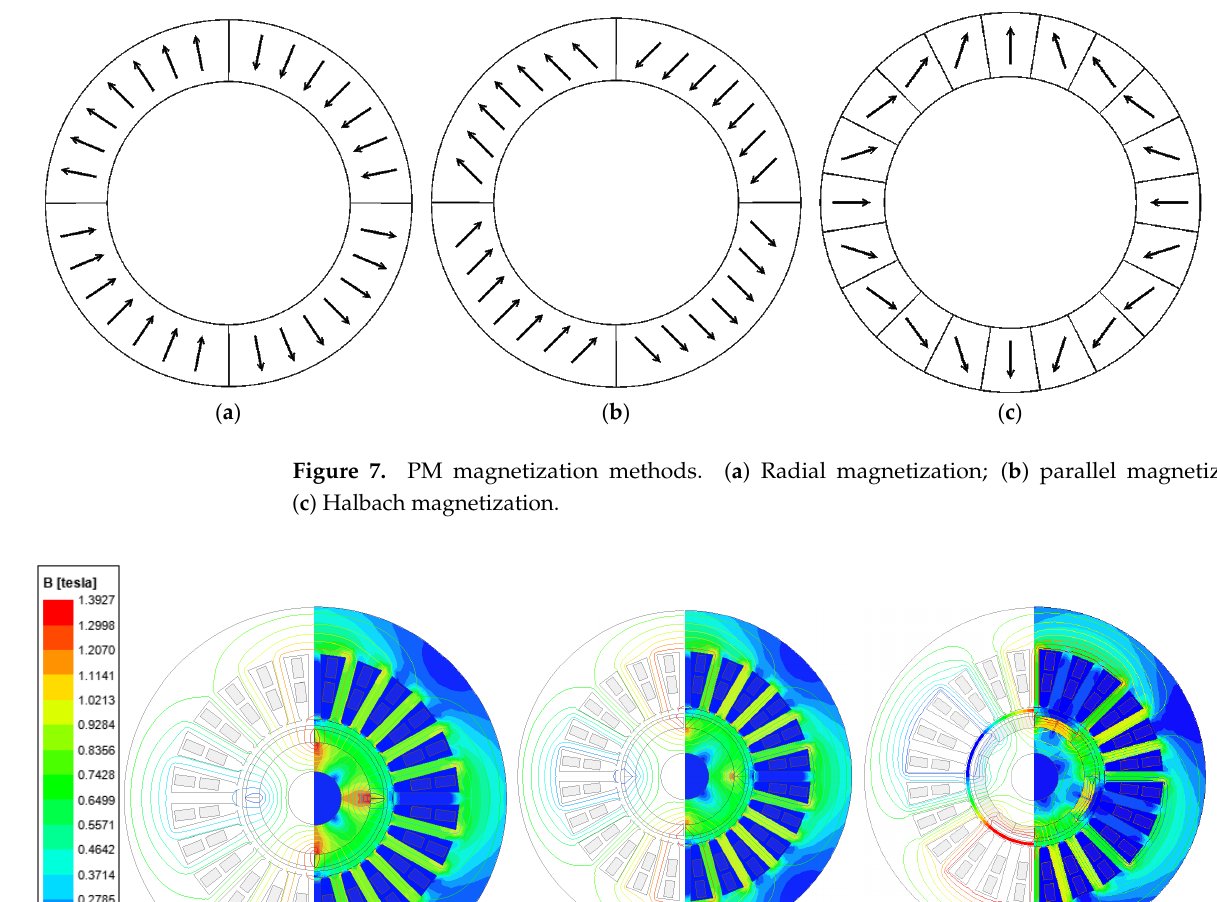
Figure 8. Magnetic flux density and lines distributions of HSPMMs with different magnetization methods under no − load condition. ( a ) Radial magnetization; ( b ) parallel magnetization; ( c ) Halbach magnetization.